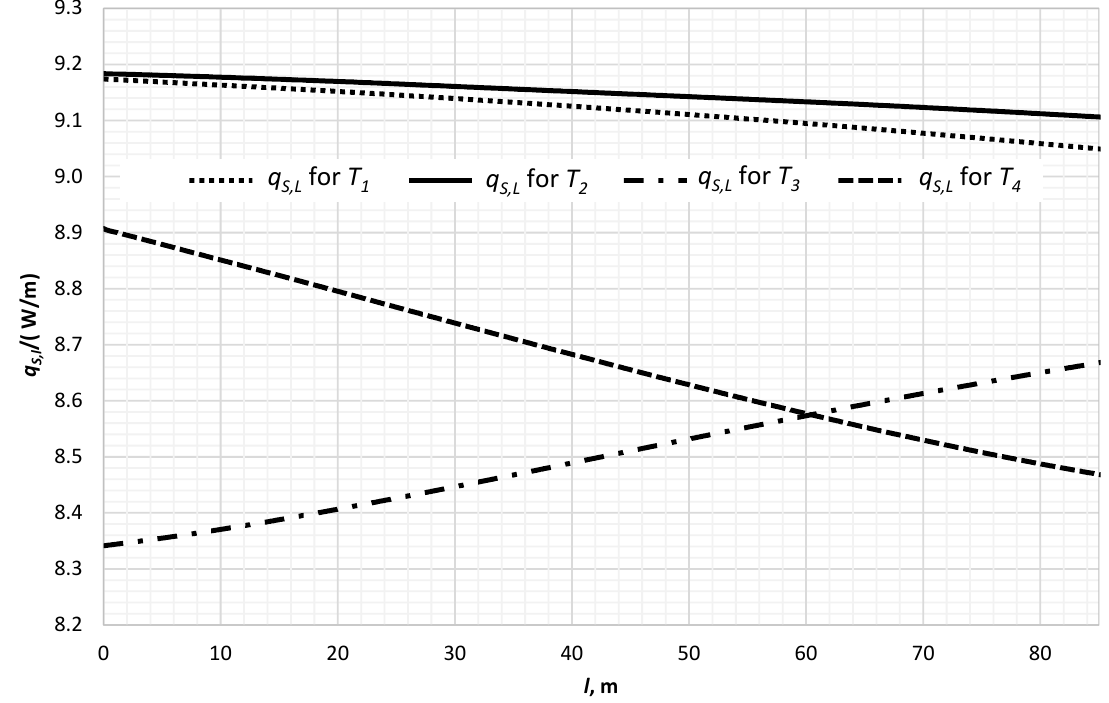
Figure 14. Distribution of heat loss along the length of the pipeline ( l = 0 m—inlet).